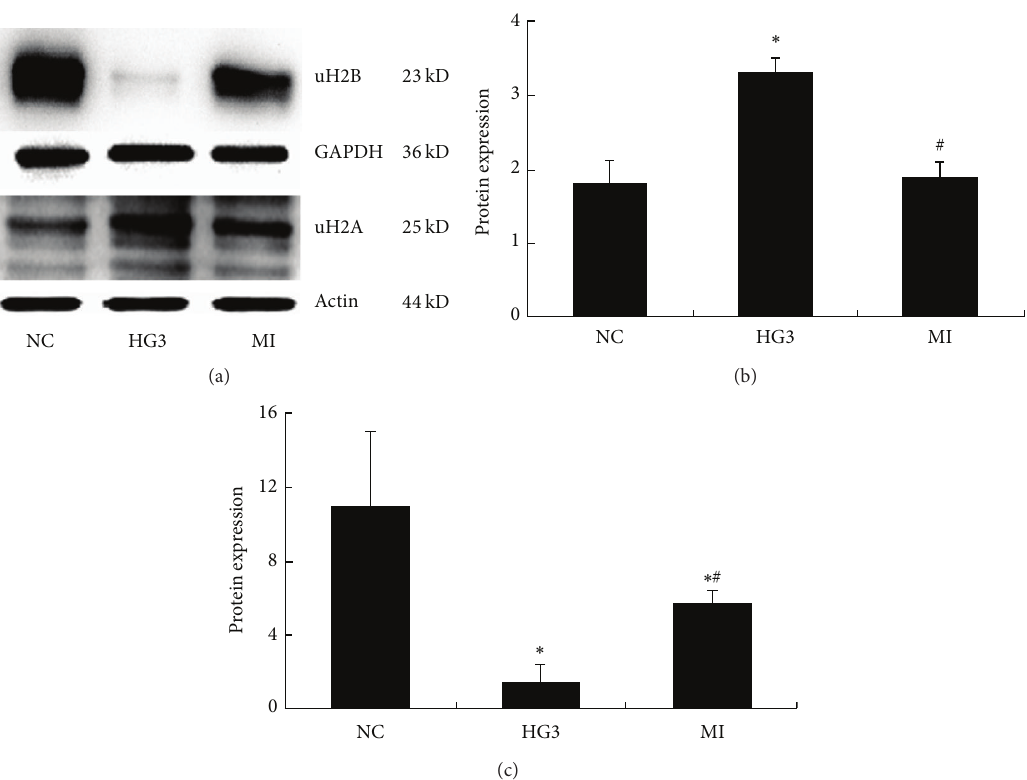
Figure 5: The expression of histone H2A and H2B ubiquitination after intervention with MG132 determined using Western blot (uH2A for 24 hr and uH2B for 48hr). (a) Western blot strip chart. (b) The gray graph shows the relative statistical values of uH2A for each group. Compared with the NC group, the expression of the uH2A protein was significantly increased in the HG3 group. After MG132 intervention, the protein expression of uH2A decreased. ∗ 𝑃 < 0.01 versus NC group and # 𝑃 < 0.05 versus 1 HG3 group. (c) The gray graph shows the relativestatisticalvaluesofuH2Bforeachgroup.ComparedwiththeNCgroup,theexpressionoftheuH2Bproteinwassignificantlydecreased in the HG3 group. And after MG132 intervention, uH2B relative to the normal group changed. ∗ 𝑃 < 0.01 versus NC group and # 𝑃 < 0.05 versus 1 HG3